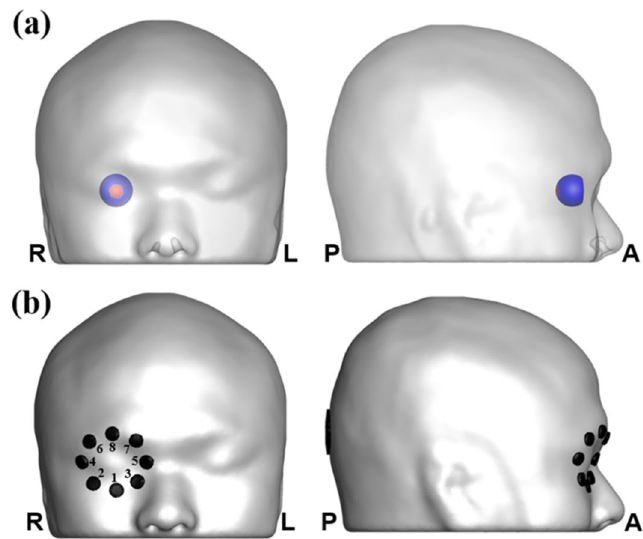
Figure 2. ( a ) Illustration of the whole retina (blue) and region of interest (ROI) (red). ( b ) Illustration of the suggested montage with eight active electrodes. The electrode number was listed next to the